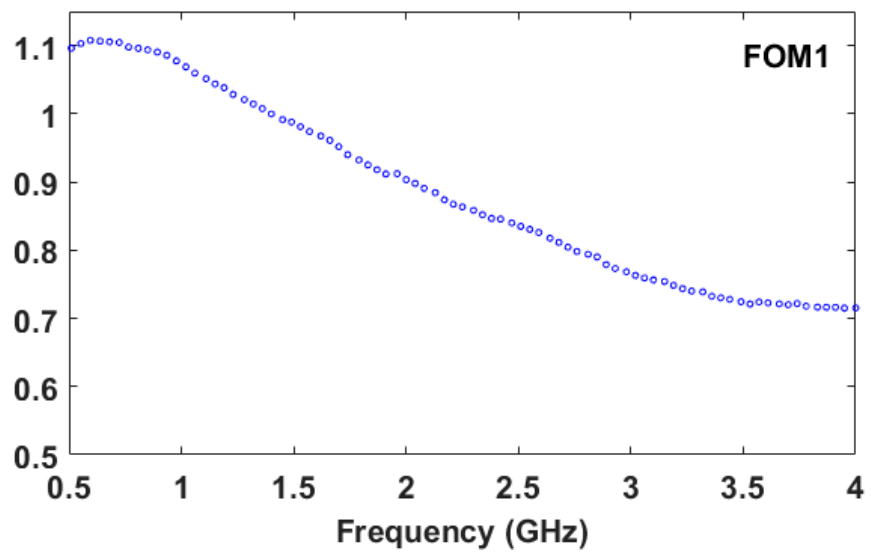
Figure 11. The FOM1 is depicted from the frequency range of 0.5–4.0 GHz.